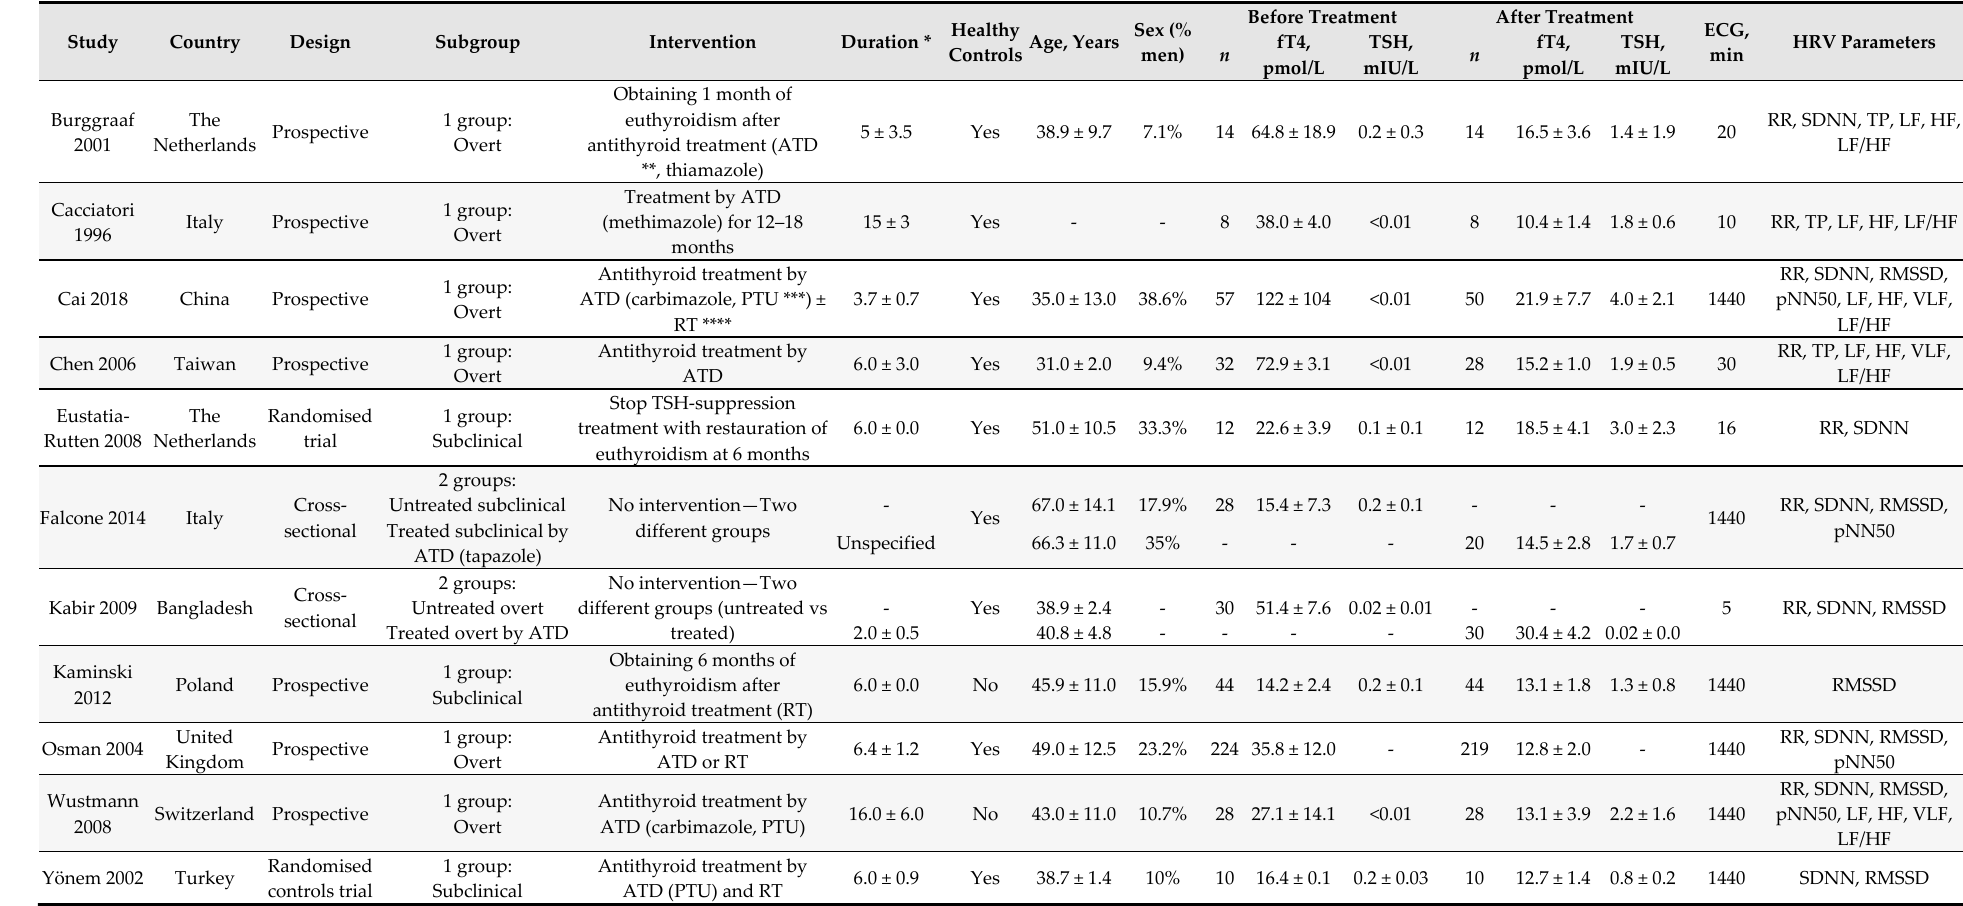
Table 2. Characteristics of included studies.